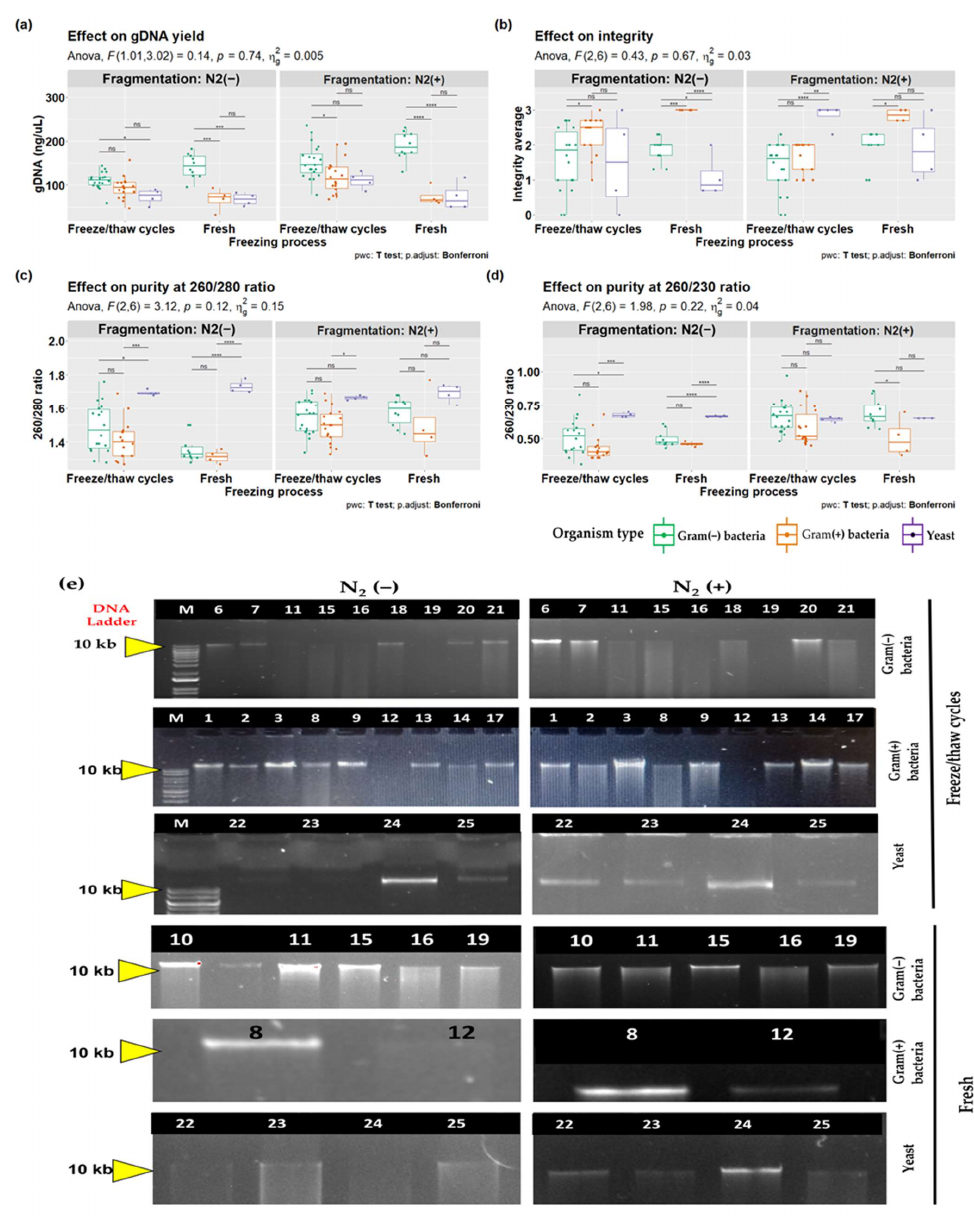
Figure 3. Effect of processing on DNA quantity and quality from isolated microorganism samples. ( a ) Box plots showing the DNA concentration (ng/μL). ( b ) Box plots showing the DNA purity at 260/280 nm. ( c ) Box plots showing the DNA purity at 260/230 nm. ( d ) Box plots showing the DNA integrity. All boxplots show the yeast, Gram(+) and Gram(−) bacteria grouped by processing and fragmentation. ( e ) Representative results from gel electrophoresis analysis of gDNA from microorganisms isolated using the CTAB-STD method. N2(+) represents maceration with liquid nitrogen, and N2( − ) represents extraction without maceration. M represents a gene ruler DNA ladder (1 Kb plus from Invitrogen™, MA, USA). The box signifies the 75% (upper) and 25% (lower) quartiles showing the distribution of 50% of the samples. The line inside the box plot represents the median. The whiskers (top and bottom) represent the maximum and minimum values. Outliers, which are beyond 1.5 times the interquartile range above the maximum value and below the minimum value, are shown with the corresponding color dot. p -values for differences between the treatments were calculated using a three-way ANOVA statistic. When the difference between regions was significant ( p < 0.05), all pairwise comparisons were tested for significance using a t -test procedure with Bonferroni significance correction. **** for p < 0.0001, *** for p < 0.001, ** p < 0.01, and * p <